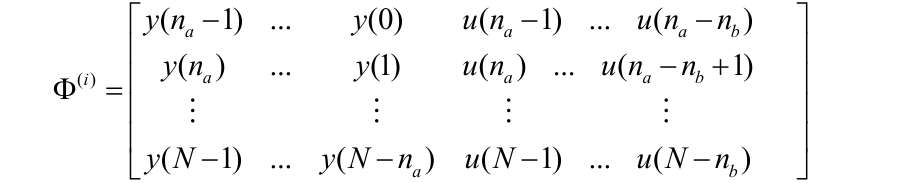
Algorithm: Extended Least-Squares method for ARX model parameters